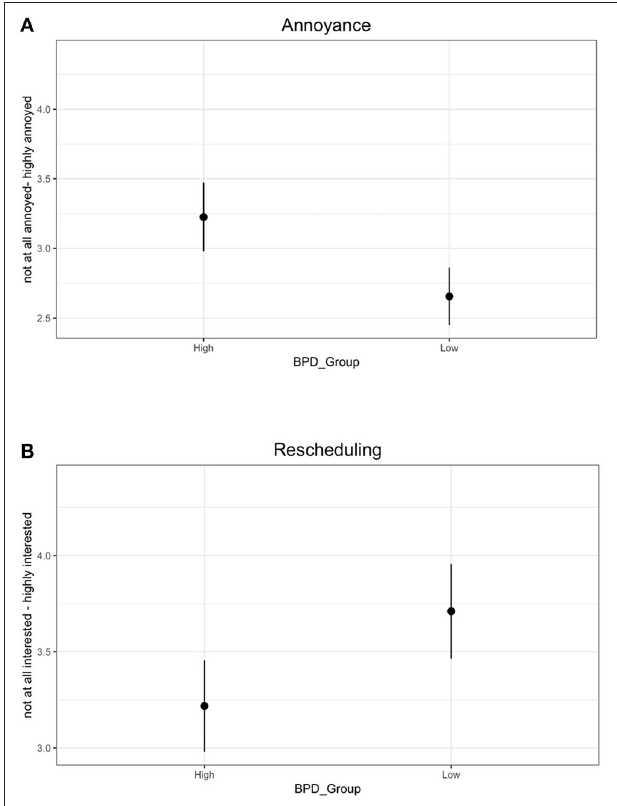
FIGURE 3 | Results from the two test questions for the High BDP and Low BPD groups. Error bars represent the confidence intervals. (A) shows responses to the annoyance question (“Rate how you would feel for each of the reasons you listed”). (B) shows responses to the rescheduling question (“Rate how interested you would be in rescheduling the coffee